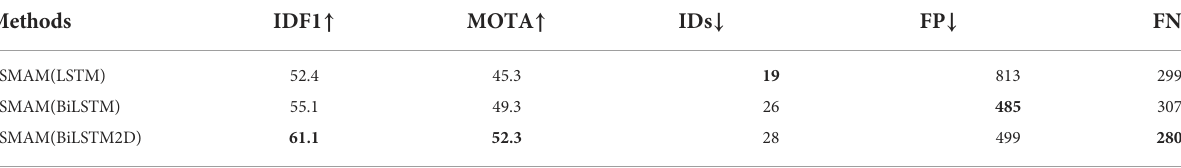
TABLE 4 Ablation study about different LSTM.